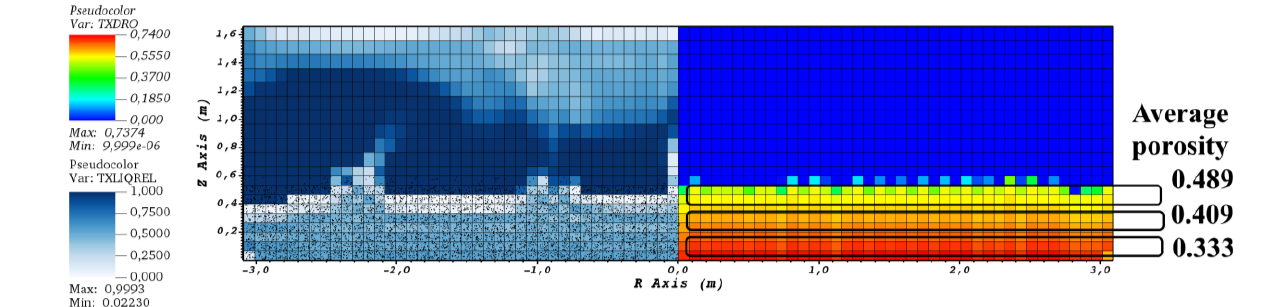
Figure 4: MC3D pre-calculation model at t = 180 s: debris ratio on the right and local liquid water ratio on the